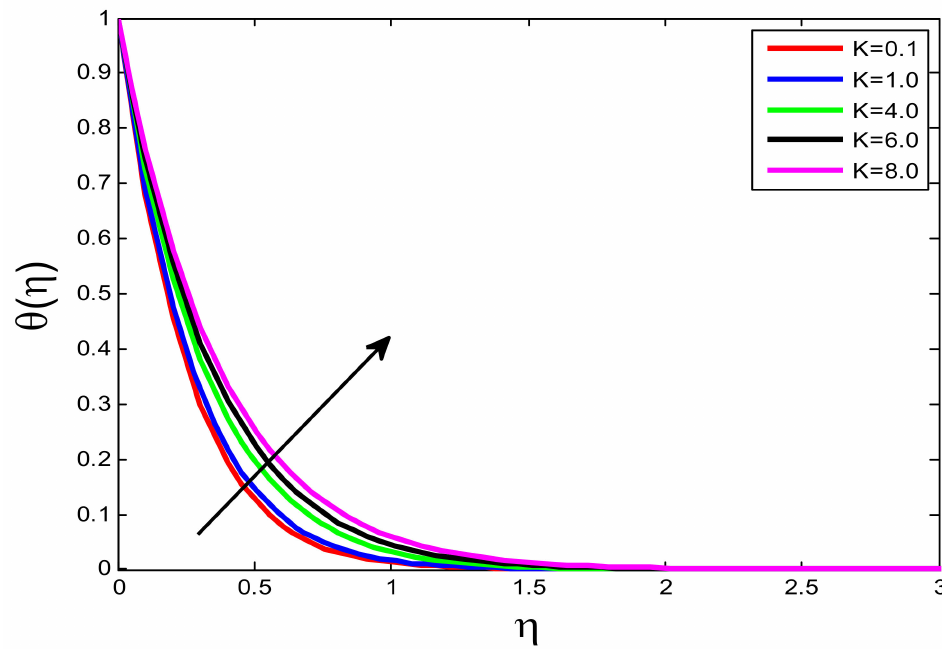
Figure 11. Influence of K on θ ( η )